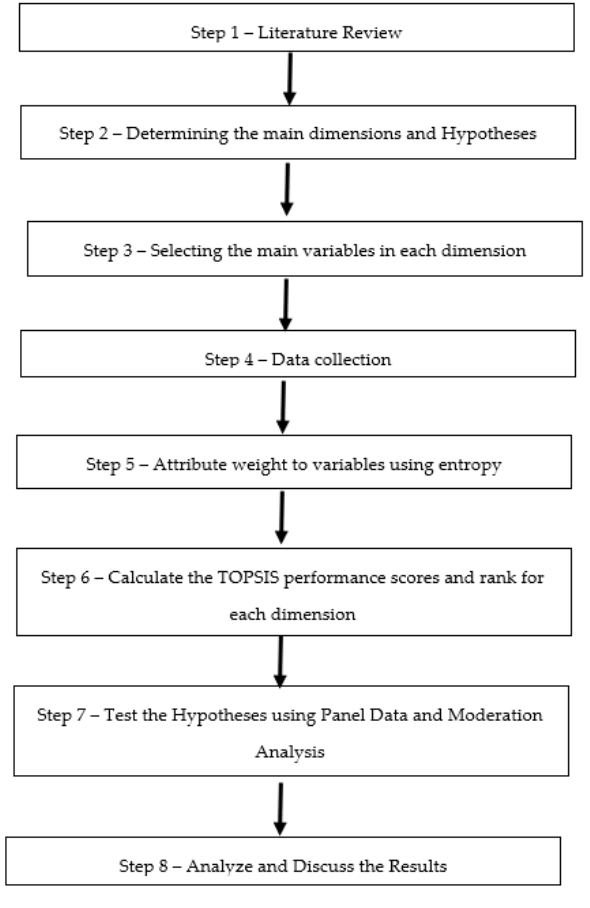
Figure 1. Main steps in the study.